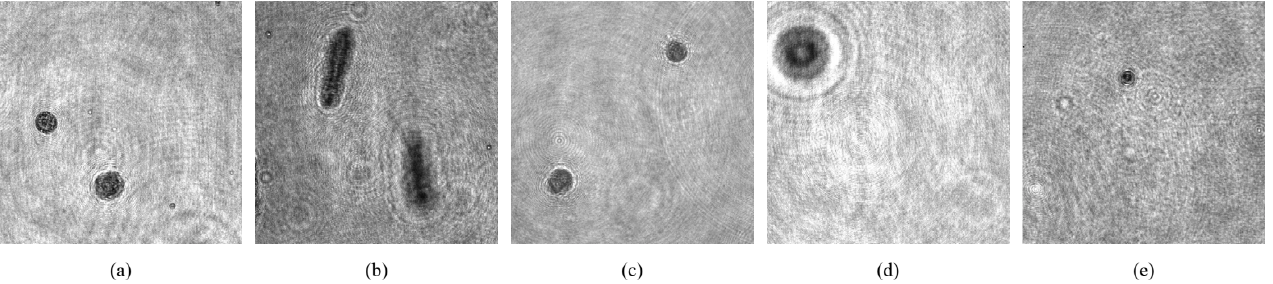
Figure 3. The holograms of the five plankton species. ( a ) The hologram of ATEC. ( b ) The hologram of CMSH. ( c ) The hologram of JAMR. ( d ) The hologram of PLGD. ( e ) The hologram of STNJ. Reconstruction